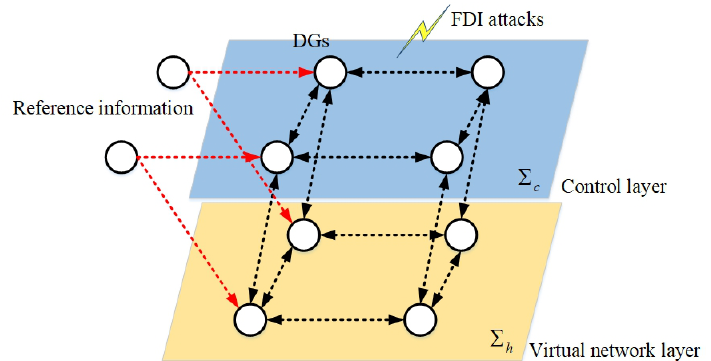
Figure 3. The layered network includes an original network Σ c and a virtual network Σ h